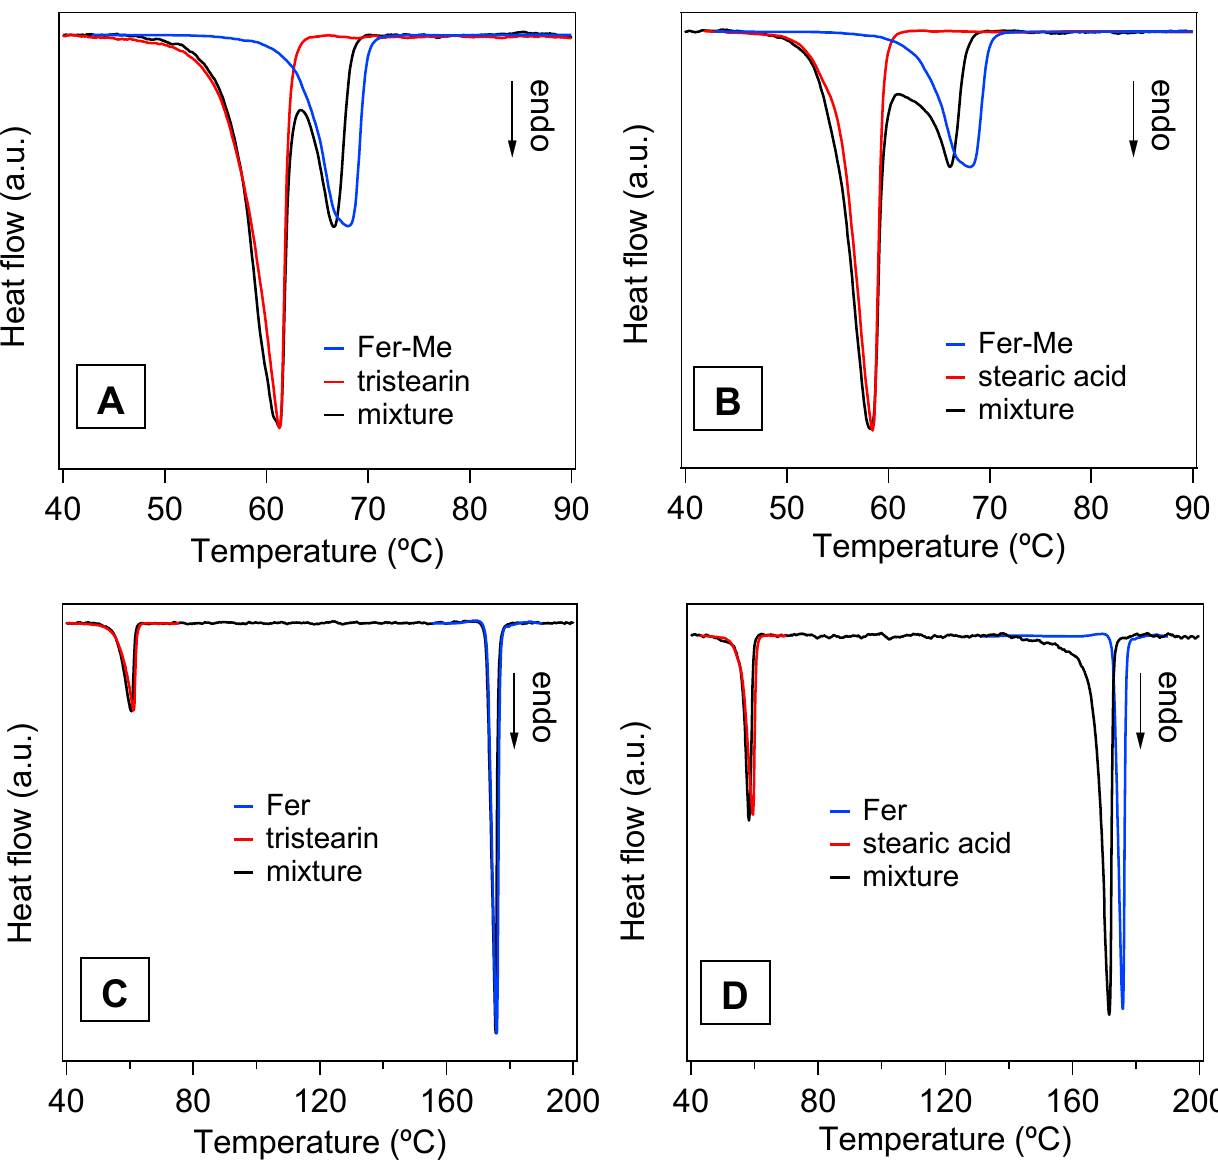
Figure 8. DSC curves of the four physical mixtures (black lines) and of those of the pure compounds, i.e., the lipid phases, tristearin and stearic acid (red lines) and the drug phases, Fer-Me and Fer (blue lines). ( A ) Fer-Me and tristearin; ( B ) Fer-Me and stearic acid; ( C ) Fer and tristearin; ( D ) Fer and stearic acid.